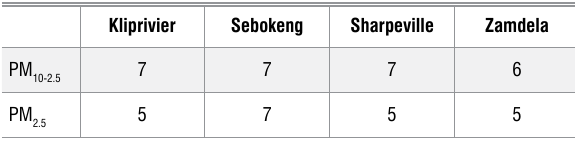
Overview of the number of factors selected for